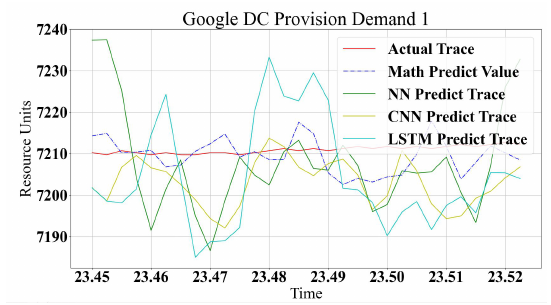
Figure 12. Google Data Center Provision Resources for WL1.